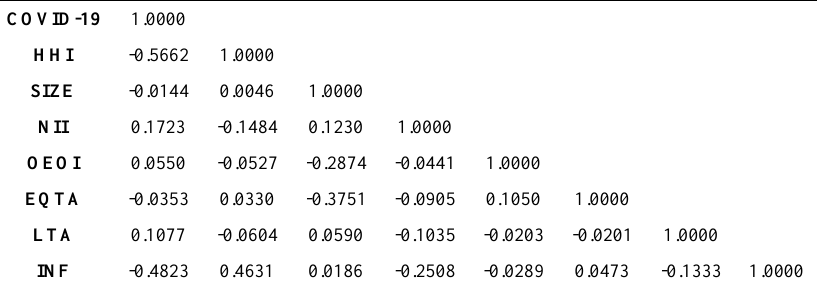
Table 2. Correlation between Independent Variables